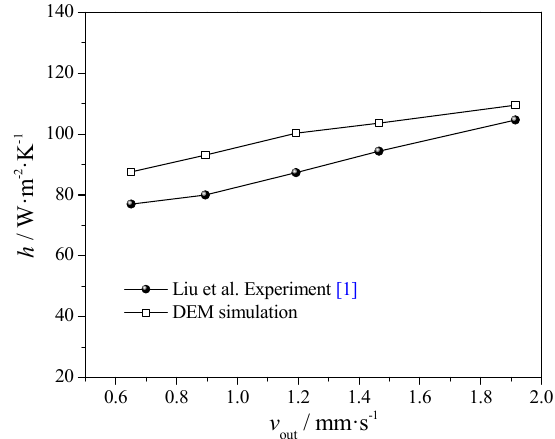
Figure 5. Comparison of heat transfer coefficients of simulation results and experimental measurement.